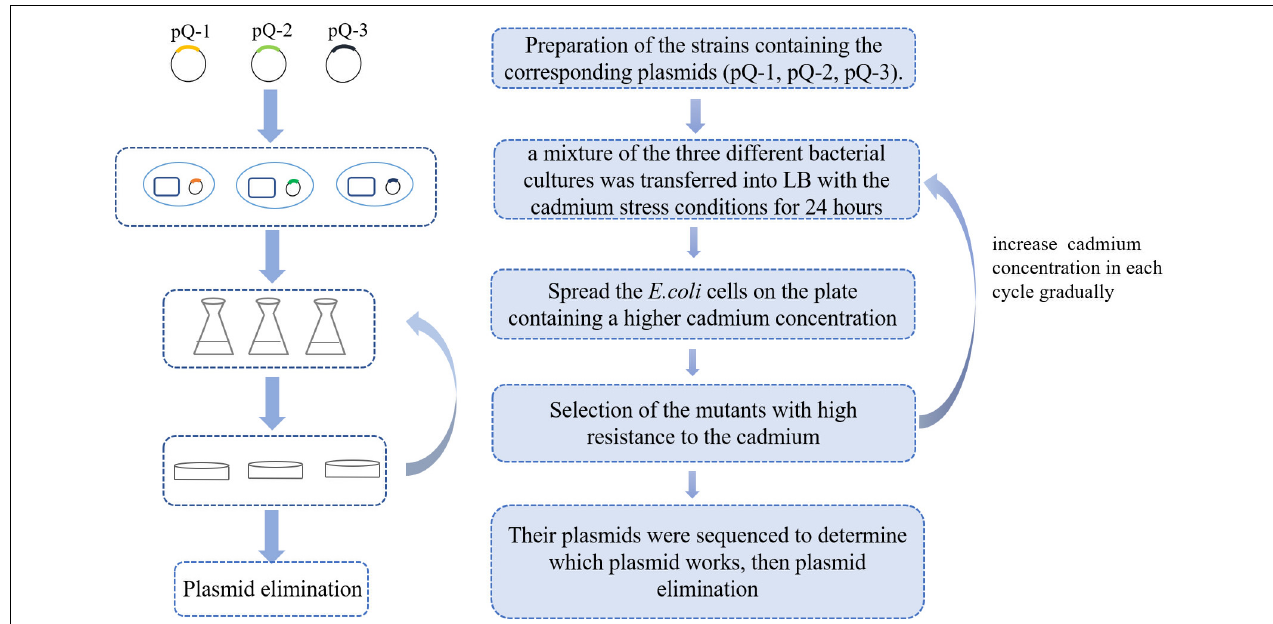
FIGURE 1 | Flowchart of the genome replication engineering-assisted continuous evolution (GREACE) method. To improve cadmium resistance, pQ-1, pQ-2, and pQ-3 were transformed into host cells [BL21(DE3)] and cultivated under conditions with gradually increasing selective strength. Evolved strains with higher cadmium resistance were selected, and the plasmids were sequenced for confirmation. Genetically modified pQ mutants were eliminated from the evolved strains to stabilize the obtained genotypes and